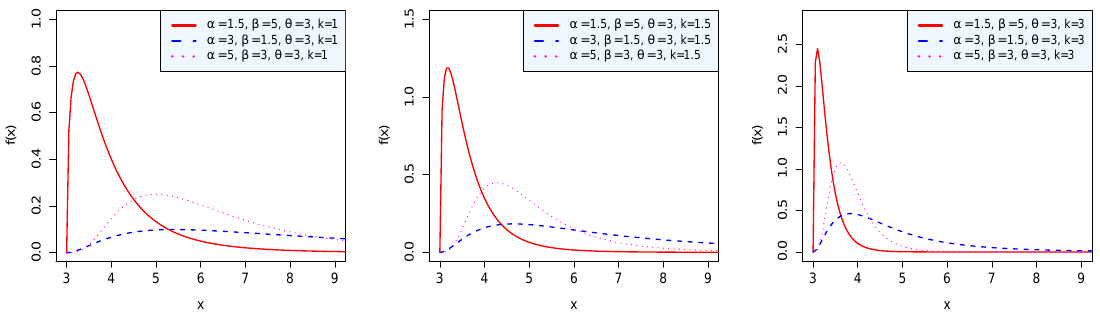
Figure 1. Density of the BP distribution.